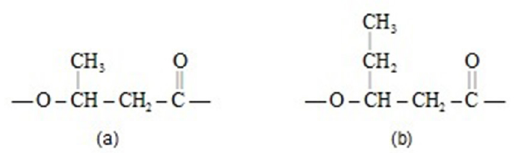
and PHB tests specimens illustrating 1 2